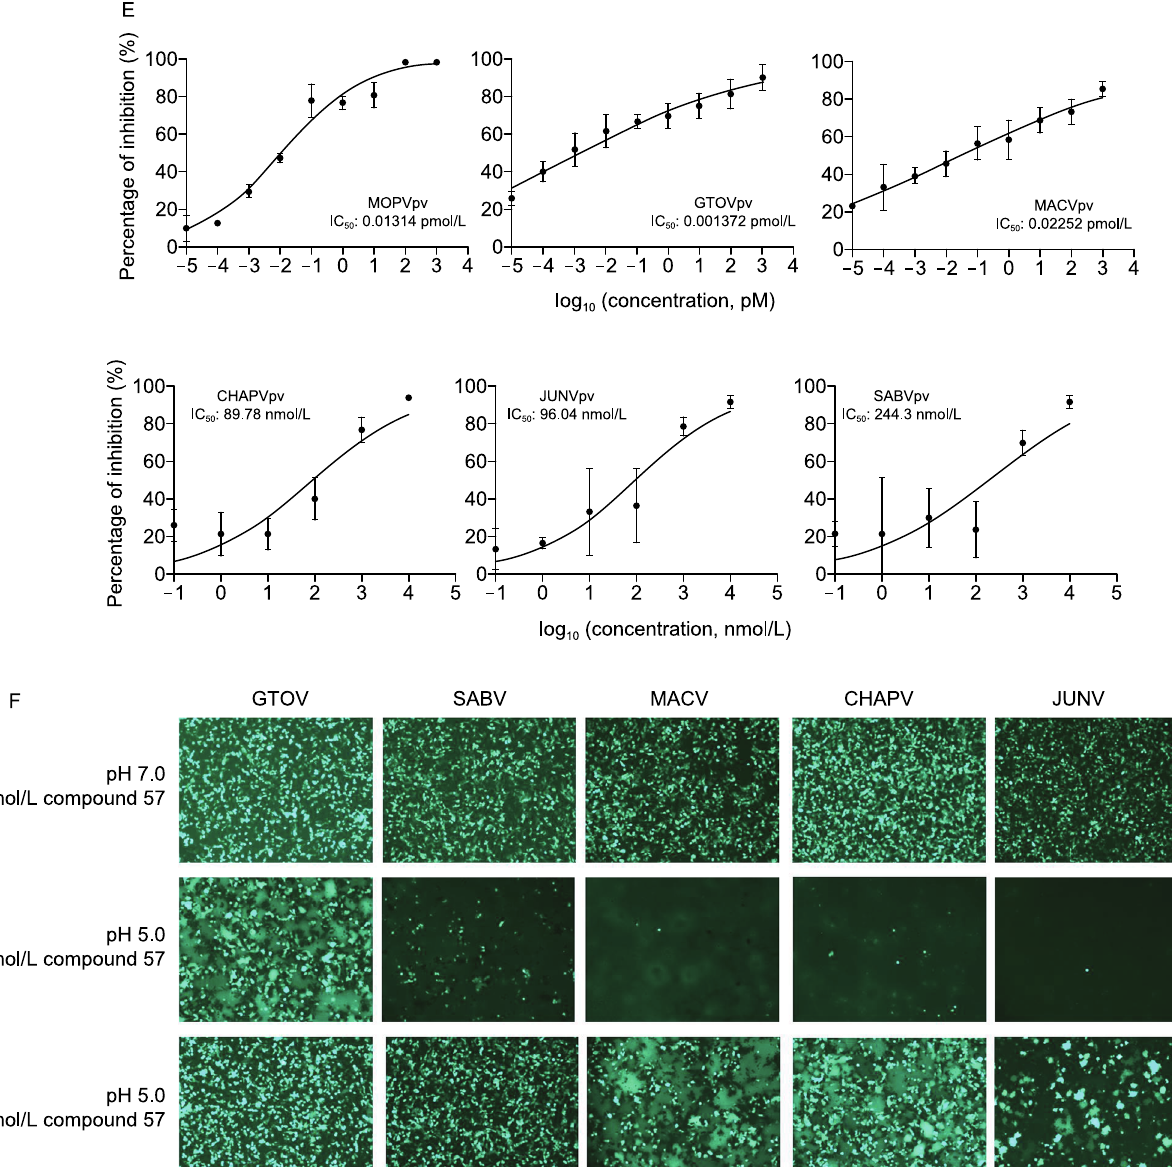
Figure 1. Inhibitory effects of the four hit compounds . (A) Dose-response curves of compounds 21, 29, 57, 72 and ST-161 for LASVpv infection of Vero cells as determined by measuring luciferase activities. Insets show the structure of each compound. (B) Hit compounds inhibited LASV GPC-mediated membrane fusion. Dual-luciferase assay was used to quantitatively evaluate the inhibitory activities of compounds against membrane fusion. Data are presented as means ± standard deviations (SD) for four independent experiments. (C) Selection of resistant LASVrv. The adaptive mutant selected by serially passaging LASVrv (MOI of 0.01) in the presence of each compound with indicated concentration. LASVrv passaging in vehicle served as a control in parallel. (D) Resistant and cross-resistant activities of the LASVpv with the adaptive mutants. Data are presented as means ± SD from three independent experiments. (E) Dose-response curves of compound 57 for inhibiting the pseudotype of MOPV and NW pathogenic arenaviruses infection. (F) Compound 57 inhibited NW pathogenic arenavirus GPC-mediated membrane fusion. Syncytium formation visualized using fl uorescent microcopy after infection of 293Tcells with pEGFP-N1 and pCAGGS-GTOV/SABV/MACV/CHAPV/JUNV GPC and treatment with compound 57. Images are representative fi elds from four or fi ve independent